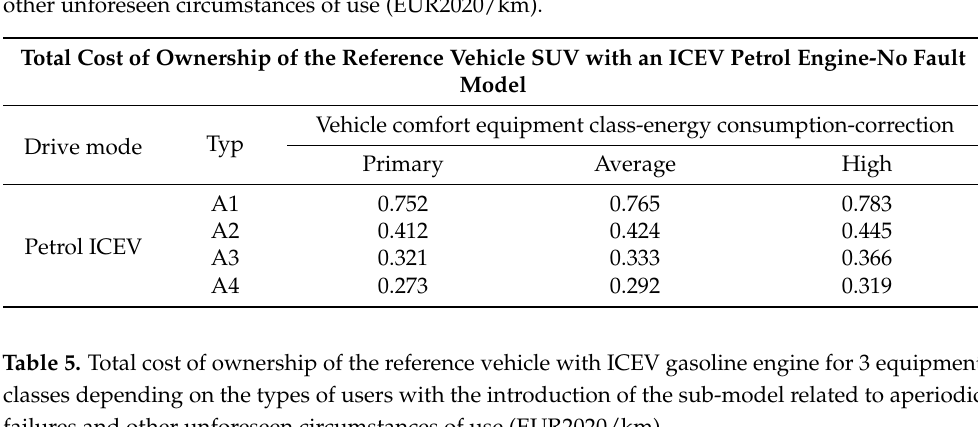
Table 4. Total cost of ownership of the reference vehicle with ICEV petrol engine for 3 equipment classes depending on the types of users, excluding the sub-model related to aperiodic faults and other unforeseen circumstances of use (EUR2020/km).